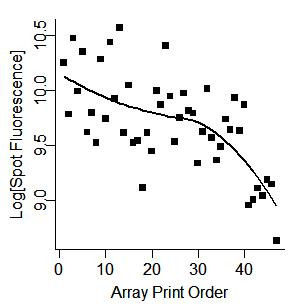
Control spot fluorescence and slide print order We expect control spot intensity to be constant across slide print order. The trend, estimated with loess regression, indicates a processing effect due to printing order. In this case, the decrease in control spot intensity, coupled with knowledge of the printing process, suggests that the quantity of printed material is decreasing over a printing run.